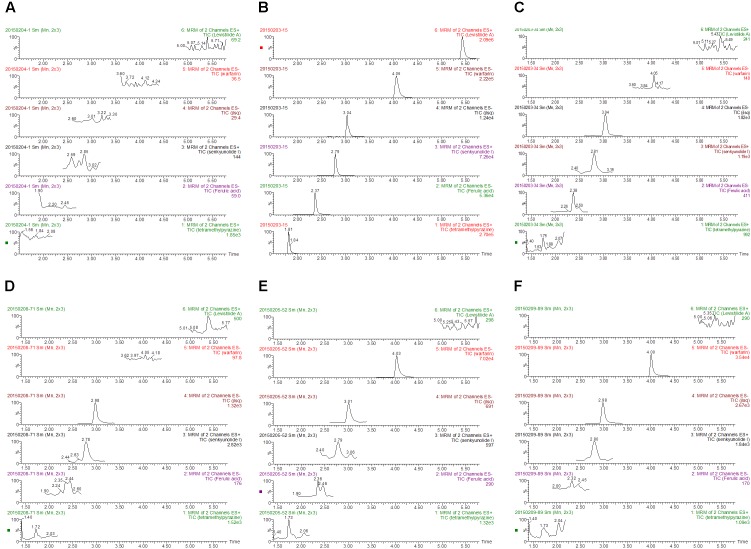
Representative MRM chromatograms of levistilide A, tetramethylpyrazine, senkyunolide I, ferulic acid, warfarin, and methyclothiazide in rats: (A) Blank plasma samples from healthy rats; (B) blank plasma samples spiked with levistilide A, warfarin, methyclothiazide, senkyunolide I, ferulic acid and tetramethylpyrazine; (C) plasma from healthy rats after a single administration of Chuanxiong; (D) plasma from rats with biliary drainage after a single administration of Chuanxiong; (E) plasma from healthy rats after the administration of warfarin and Chuanxiong; (F) plasma from rats with biliary drainage after the administration of warfarin and Chuanxiong (from the top to the bottom: levistilide A, warfarin, methyclothiazide, senkyunolide I, ferulic acid, and tetramethylpyrazine).